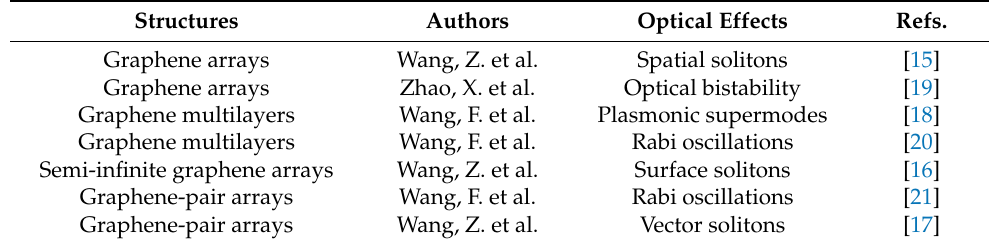
Table 1. Research progress on graphene arrays. Structures Authors Optical Effects Refs. Graphene arrays Wang, Z. et al. Spatial solitons Graphene arrays Zhao, X. et al. Graphene multilayers Semi-infinite graphene arrays Graphene-pair arrays Graphene-pair arrays Wang, Z. et